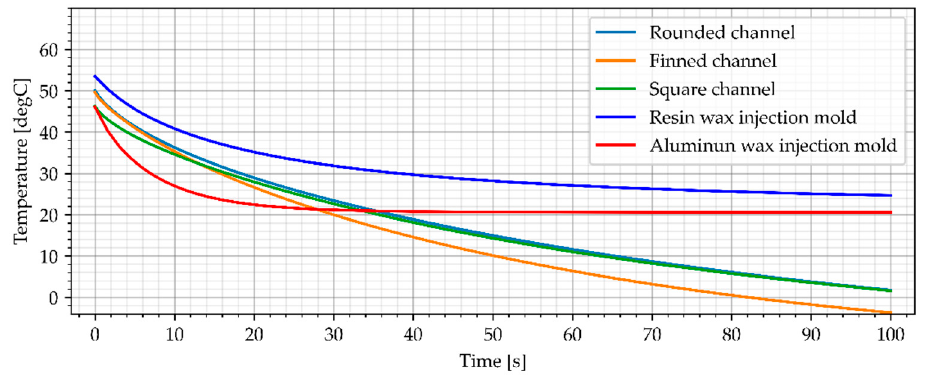
Figure 22. The sample temperature for air cooled wax injection molds (middle point).